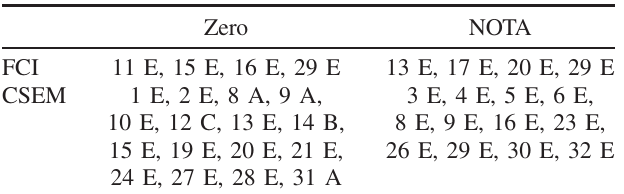
TABLE I. Zero and NOTA options identified in the FCI and